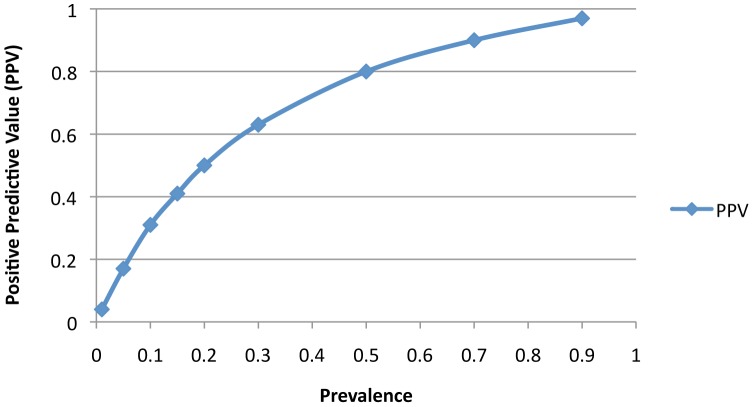
β-D-Glucan Positive Predictive Value as a function of varying Disease Prevalence.The positive predictive value of two sequential β-D-Glucan test results ≥80 pg/ml is plotted relative to increasing invasive candidiasis prevalence. Sensitivity and specificity have been fixed at 100% and 75%, respectively.